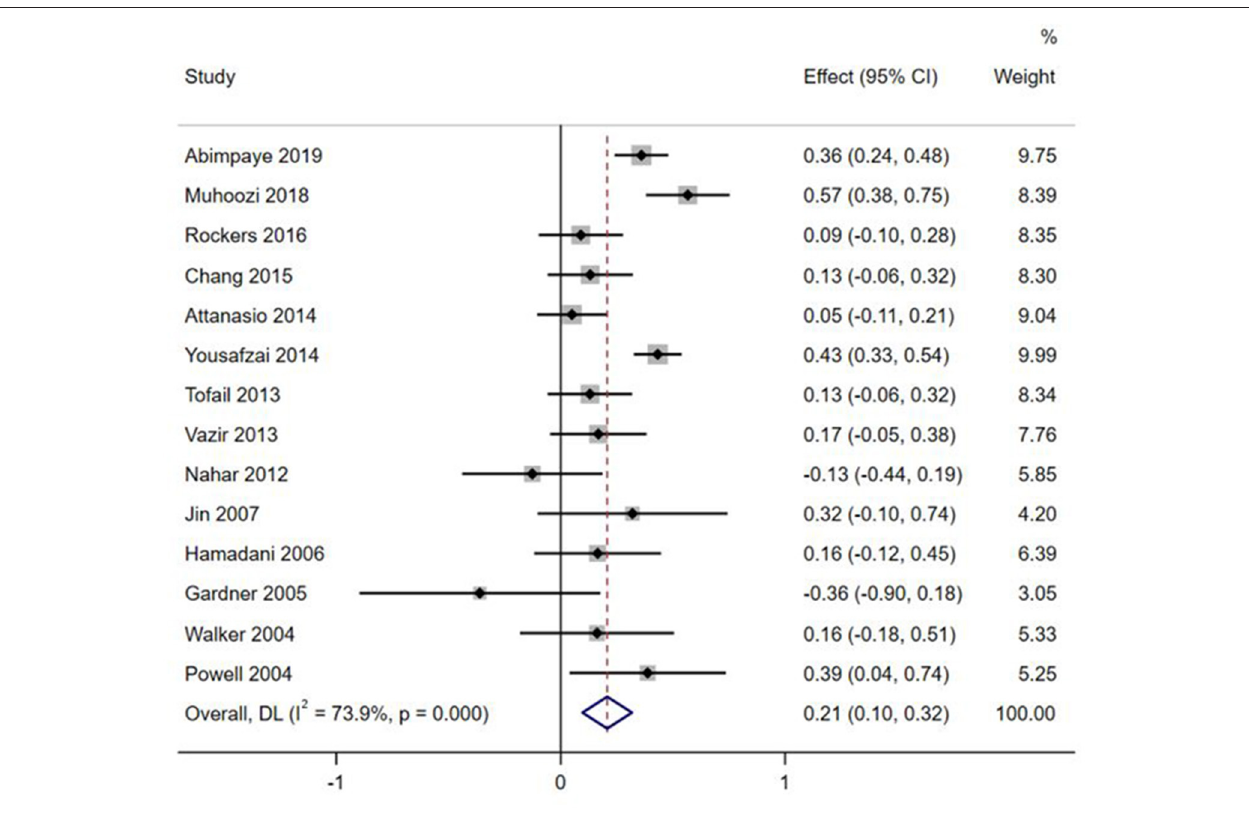
FIGURE 4 | Effect sizes on Motor outcomes.